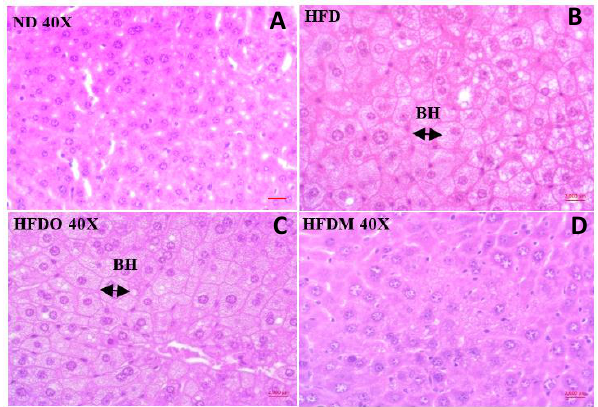
Figure 11. Effect of high-fat diet on hepatic ballooning in the HFD-fed obese mice at 40x magnification. The HFD group was prone to develop hepatic ballooning. Treatment with MESK completely prevented hepatic lipid deposition and hepatic ballooning. ( A : ND: normal diet, B : HFD: high-fat diet, C : HFDO: HFD + Orlistat, D : HFDM: HFD + MESK). Arrow indicates a higher diameter of ballooned hepatocytes. The ballooned hepatocytes also displayed clear cytoplasm and appeared white in color. Hepatocytes of the normal diet and MESK-treated group showed normal liver architecture and cell size. BH: Ballooned hepatocytes. Scale bar indicates 2000 µm.